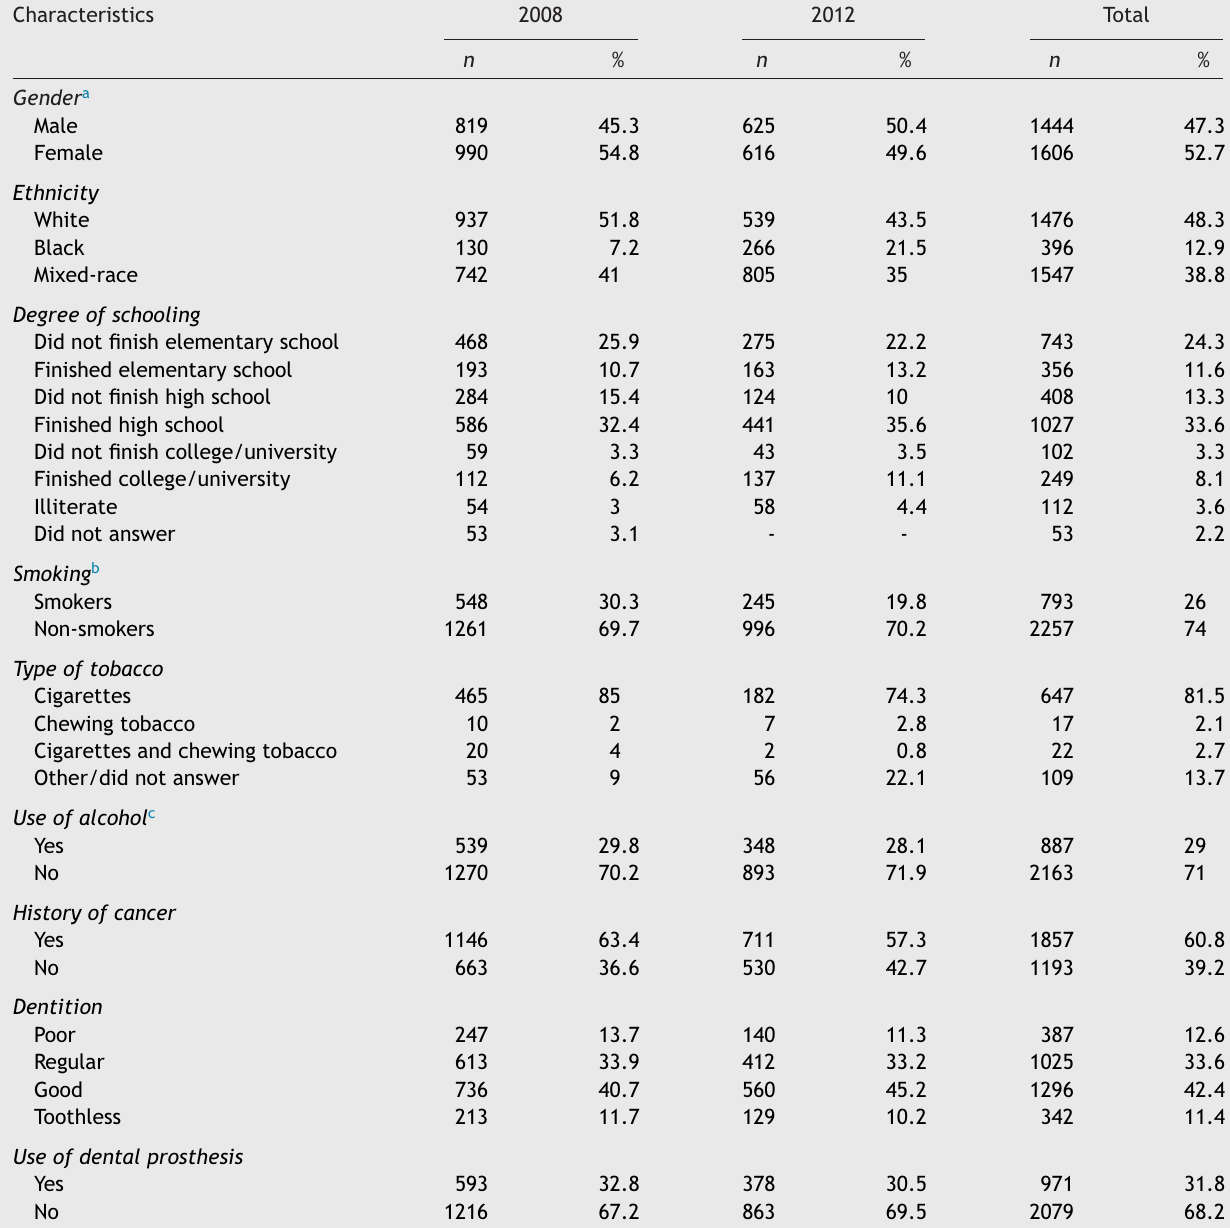
Table 2 Epidemiological characteristics of the individuals attended to in the 2008 and 2012 campaigns.